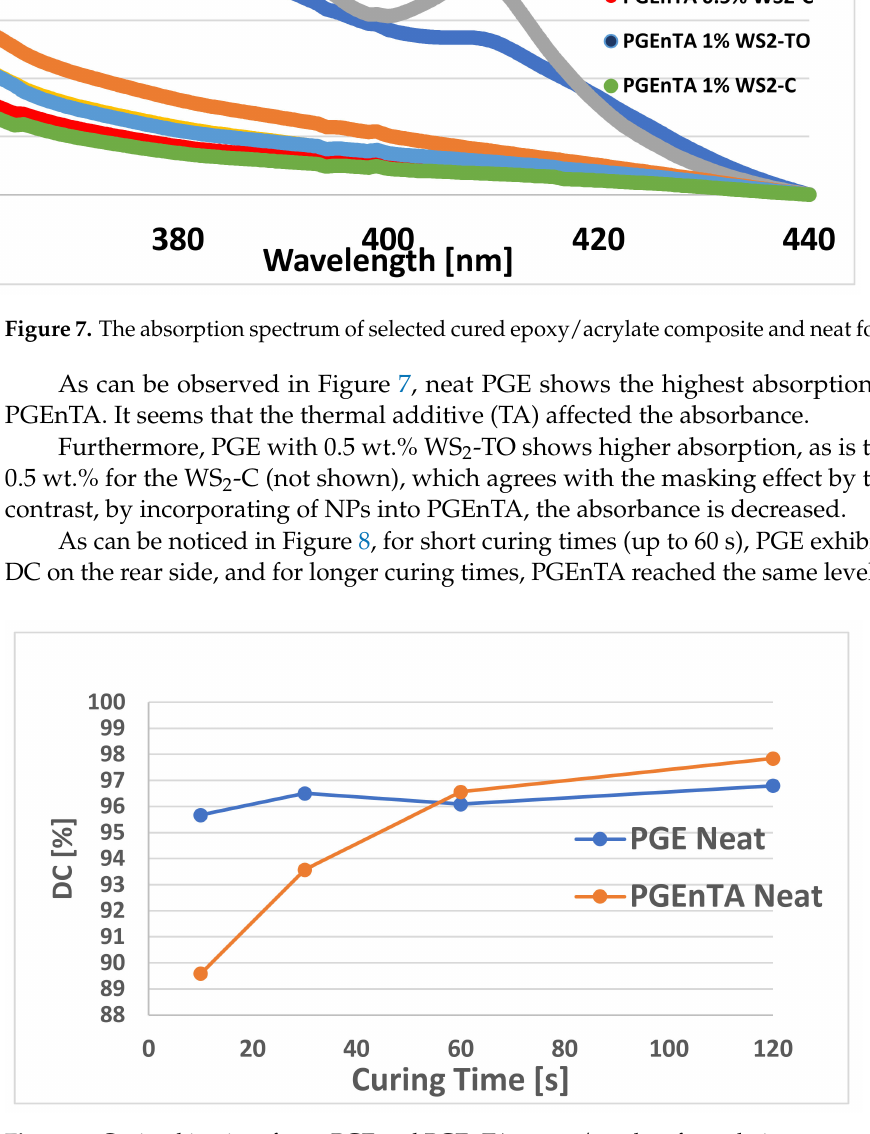
Figure 8. Curing kinetics of neat PGE and PGEnTA epoxy/acrylate